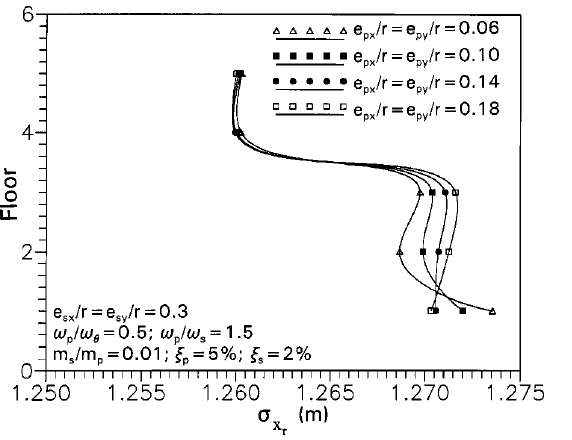
Fig. 8. Variation of (cid:27) x with storey height for various values of r e p x =r and e p y =r ; for m s =m p = 0.01; ! p =! s = 1.5; ! p =! (cid:18) = 0.5; e